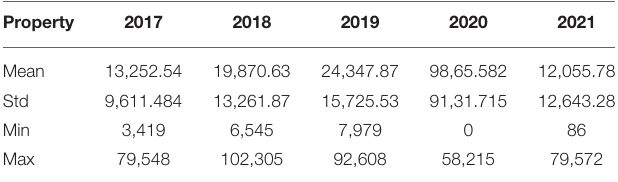
TABLE 1 | The datasets used in our experiments.